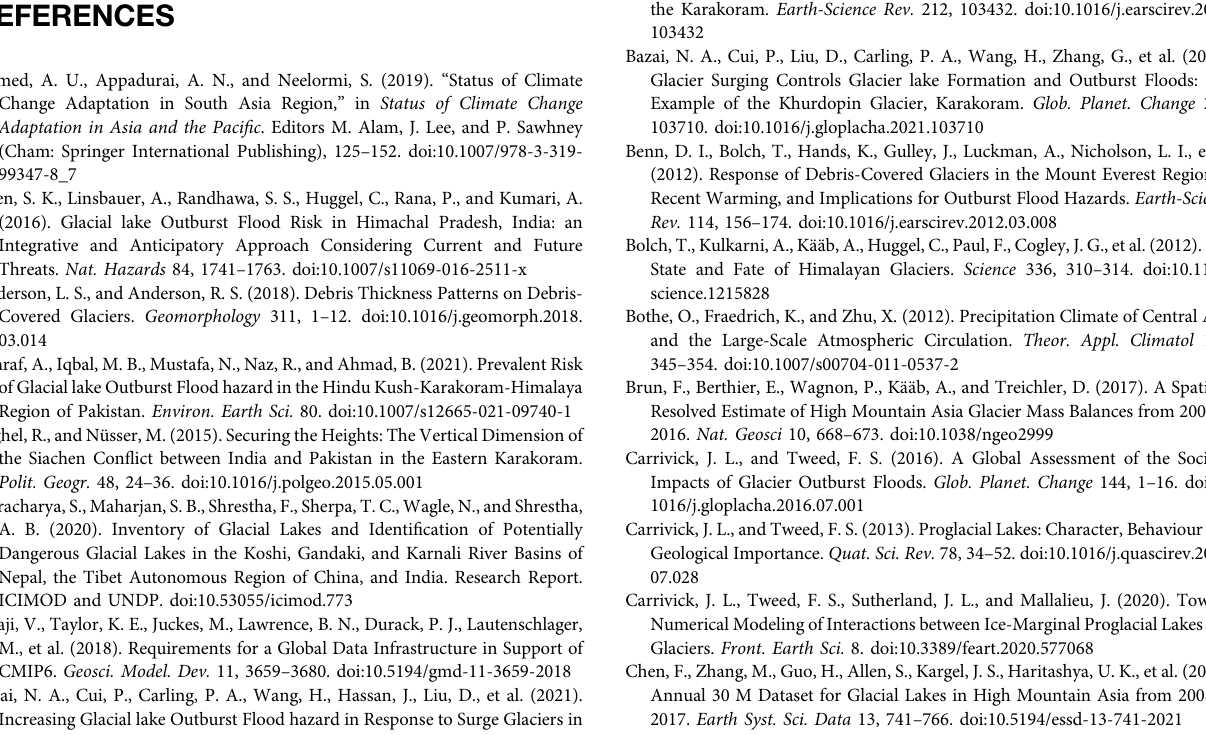
Supplementary Figure 1 | Individual results of 15 CMIP6 GCMs on the development of glacial lake area in HMA under different SSP scenarios. The dashed lines represent the state of HMA ’ s glacier lakes ( > 1 km 2 ) in 2018, following Shugar et al. (2020). Supplementary Figure 2 | Individual results of 15 CMIP6 GCMs on the development of glacial lake volume in HMA under different SSP scenarios. The dashed lines represent the state of HMA ’ s glacier lakes ( > 1 km 2 ) in 2018, following Shugar et al. (2020). Supplementary Figure 3 | Examples of the coherence between modeled glacial lakesandlakesexistingin2018accordingtoShugaretal.(2020).Depictedare (A) a potentially realistic estimate of the future lake development in 2030 and 2050, (B) a potential overestimation of lake area in 2030, as well as a small (C) and a large (D) underestimation of potential lake